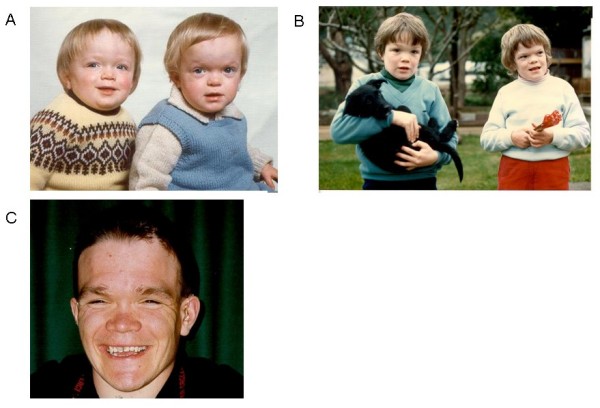
Facial features in alpha-mannosidosis. A. Twins aged 18 Months. Note enlarged head, short neck, rounded eyebrows, saddle nose, and prominent forehead. B. Same twins aged 8 years. Note slight muscular atrophy of the hands. C. Boy, aged 27. Note: Hearing aid.